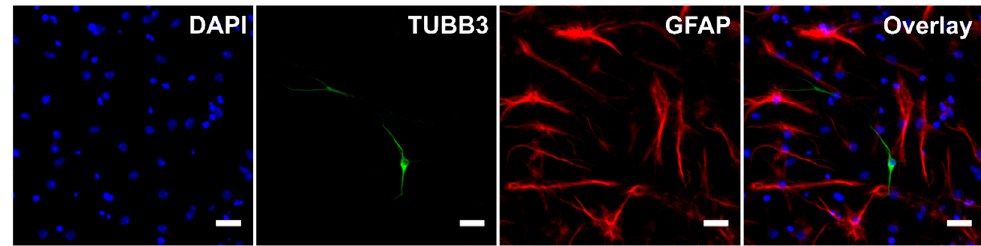
Figure 1. Immunocytochemistry. Representative image of cells after five days of differentiation without any treatment. Scale bar represents 20 µm. For the purpose of this image, gamma for GFAP channel was adjusted.